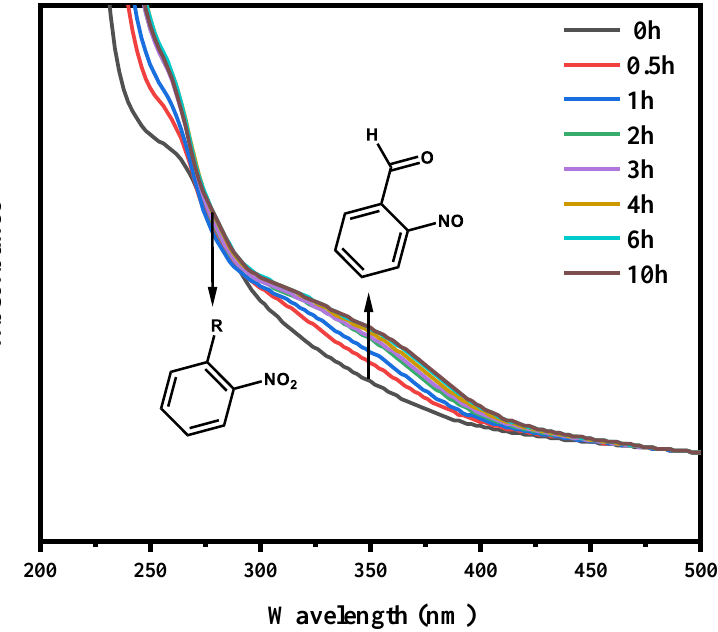
Figure 3. UV-vis spectra of PEG- b -PNSN 11 - co -PNPE 24 in aqueous solution (0.5 mg/mL) with different UV-irradiation times.